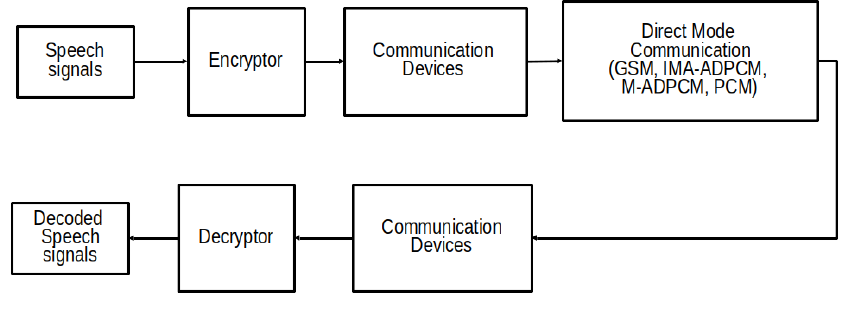
Figure 3. The process of creating the data for the experiments. IMA, Interactive Multimedia Association; M,